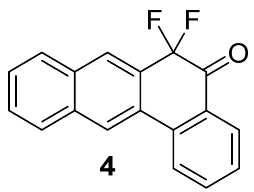
Figure 1. 6,6-Difluorotetraphen-5(6 H )-one 4